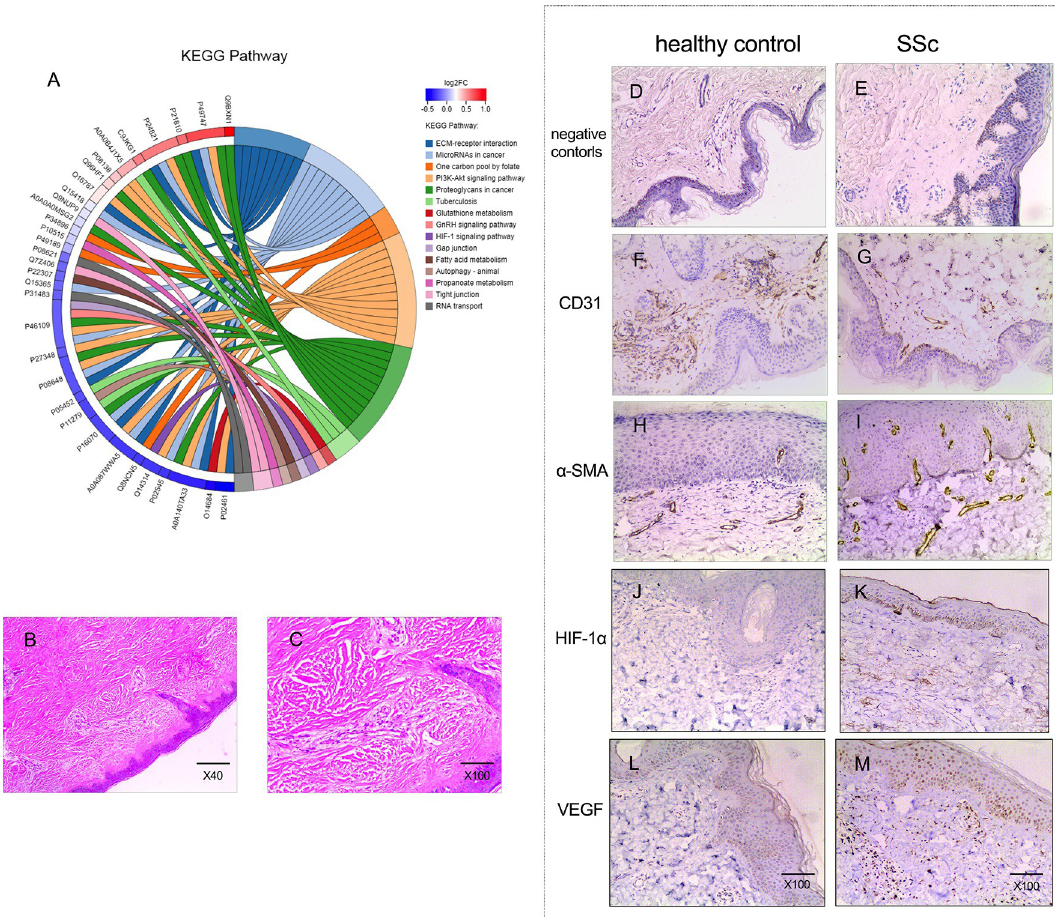
Fig 1. The iTRAQ-based proteomics, and the histopathologic and immunohistologic assessments of skin tissues obtained from patients with SSc. (A) The KEGG pathway enrichment analysis (patients n = 4, controls n = 4). (B and C) Hematoxylin and eosin staining of skin tissues at low and high magnifications from SSc patients. (D and E) Original magnification X100. Negative controls for immunohistochemistry. (F, G, H and I) Immunohistochemical staining of CD31 and α -SMA for both healthy controls (n = 8) and SSc patients (n = 8). The expression of CD31 on patients’ tissue (n = 8) decreased and α -SMA up-regulated, compared with it on healthy controls (n = 8) (J, K, L, and M) Immunohistochemical staining of HIF-1 α and VEGF for both healthy controls (n = 8) and SSc patients (n = 8). The HIF-1 α and VEGF signaling on the specimen from SSc patients were positive, however, the HIF-1 α signaling was not detected and VEGF was lowly expressed on the tissue of healthy